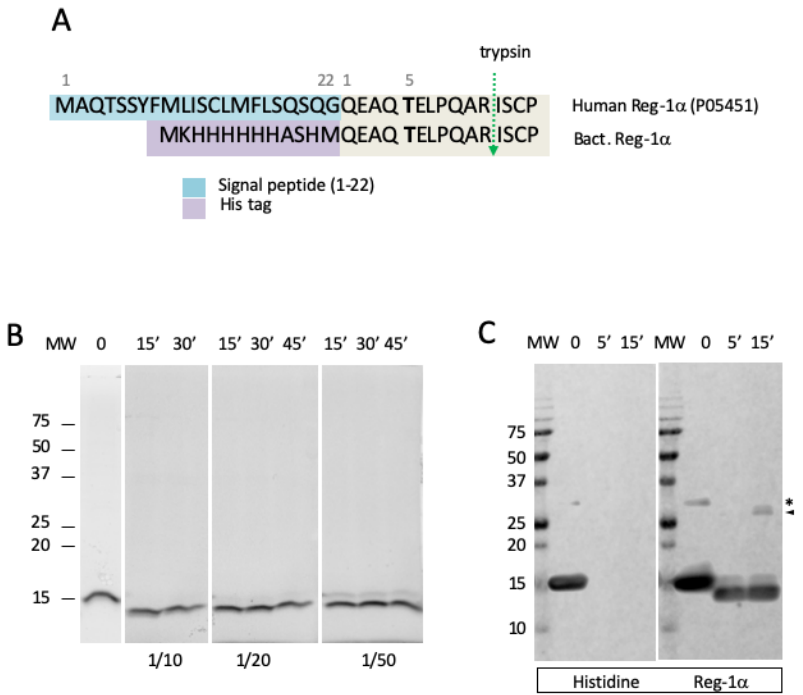
Figure 1. Reg-1 α is a new calpain-2 substrate in vitro. ( A ) NH2 terminal sequence of human Reg-1 α , including the signal peptide (blue box) compared to the isoform expressed in bacteria including the His-tag (purple box). The glycosylated Thr is noted in bold, and the position of the trypsin cleavage is indicated by a green arrow. ( B ) Intact and cleaved molecules with samples corresponding to the test of various ratio ( w/w ) of enzyme/substrate (1/10, 1/20 and 1/50) during different periods of time (0, 15, 30 and 45 min) were analyzed on 13.5% acrylamide gel and visualized using the Stain-Free Imaging Technology (see Section 4). ( C ) The uncleaved/cleaved (enzyme/substrate ratio 1/10) products were examined by western blotting using anti-Histidine and anti-Reg-1 α antibodies. Note the presence of dimers (*) and cleaved dimers (arrowhead) which resist complete reduction.